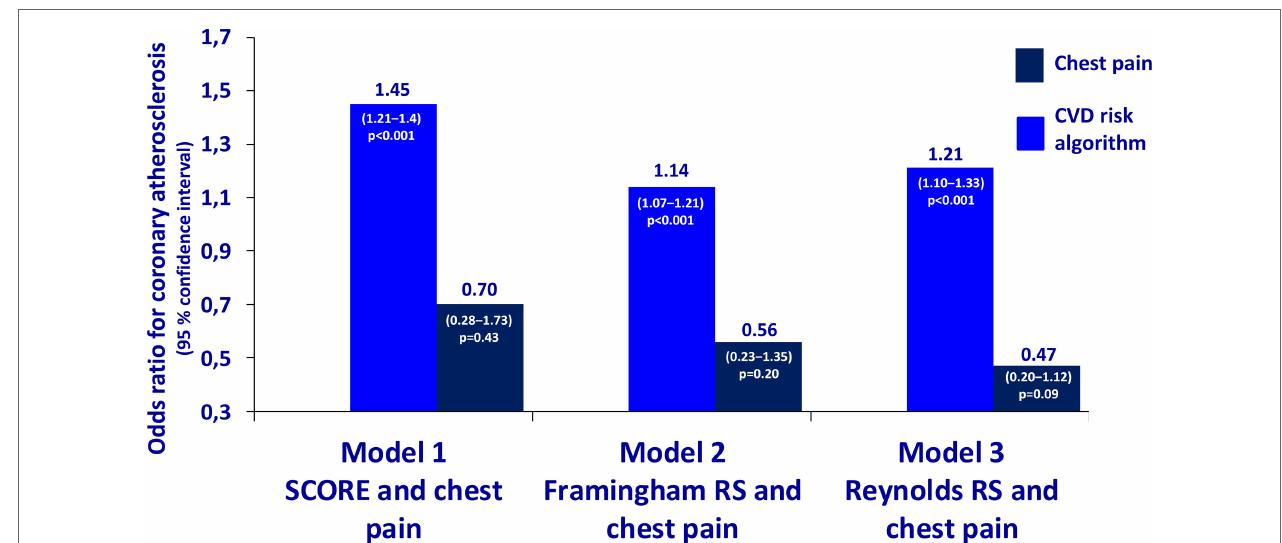
FigUre 3 | Odds ratios for coronary atherosclerosis in ra and as . Association of coronary atherosclerosis with chest pain and the calculated CVD risk by several risk calculators in patients with rheumatoid arthritis and ankylosing spondylitis. Statistics: the estimates are presented as odds ratios for the presence of CA. The odds ratios are analyzed per unit increase of CVD risk calculated by SCORE, Framingham Risk Score, and Reynolds Risk Score. RA, rheumatoid arthritis; AS, ankylosing spondylitis; SCORE, systematic coronary risk evaluation; CVD, cardiovascular